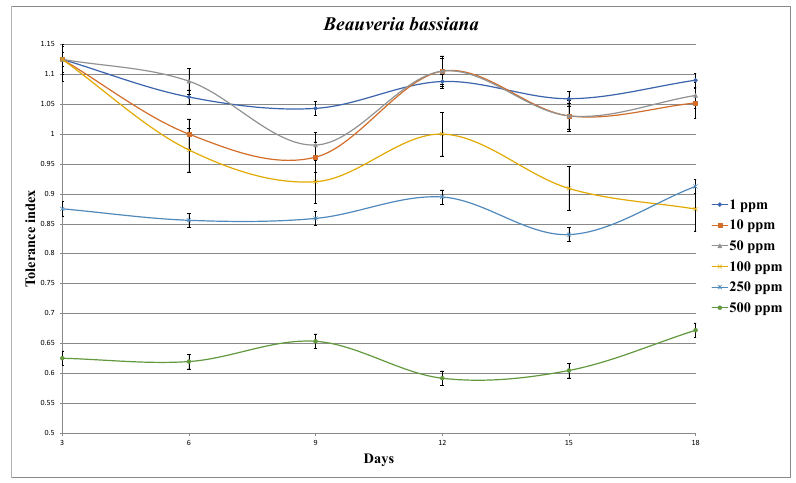
Fig. 1 Effect of an increasing Sn 2+ concentration on the tolerance index of Beauveria bassiana over an 18-day incubation period.